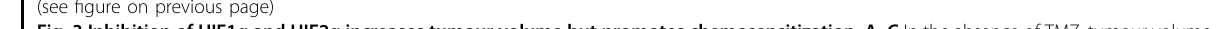
Fig. 3 Inhibition of HIF1 α and HIF2 α increases tumour volume but promotes chemosensitization. A – C In the absence of TMZ, tumour volume and weight were decreased after HIF1 α or HIF2 α -KO individually compared with the empty vector control, but the dual HIF1 α and HIF2 α knockout group had a larger tumour volume and tumour weight than the other three groups. After TMZ treatment (2 mg/kg), the tumour volume decreased after HIF1 α and HIF2 α knockout individually or simultaneously, and the smallest tumour volume was observed in the group with dual HIF1 α and HIF2 α knockout. In addition, the group with dual HIF1 α and HIF2 α knockout had the lowest tumour weight among all the groups. D , E In the absence of TMZ, the survival time became longer after HIF1 α or HIF2 α knockout individually, but the survival time was shorter in the dual HIF1 α and HIF2 α knockout group than in the other three groups (median survival time of the empty vector group vs HIF1 α -ko vs HIF2 α -ko vs HIF1 α /HIF2 α -ko group = 26 vs 31 vs 27.5 vs 22 days). However, after TMZ treatment (2 mg/kg), the HIF1 α or HIF2 α knockout group experienced prolonged survival, and the longest survival time was observed in the group with dual HIF1 α and HIF2 α knockout (median survival time of the empty vector group vs HIF1 α -ko vs HIF2 α -ko vs HIF1 α /HIF2 α -ko group = 30 vs 35 vs 34 vs 41 days). F The above cells were cultured in 1% O 2 for 72 h in the absence of TMZ, and there were no signi fi cant differences in cell proliferation between the HIF1 α -KO, HIF2 α -KO and control empty vector groups. However, after knocking out both HIF1 α and HIF2 α , the growth rate became the highest among all the groups. G The above cells were cultured in 1% O 2 for 72 h, and TMZ (400 μ M) was added to the culture medium for an additional 72 h. After HIF1 α or HIF2 α was knocked out individually, cell proliferation decreased. After both HIF1 α and HIF2 α were knocked out, the growth rate became the lowest among all the groups. H The above cells were cultured in 1% O 2 for 72 h, and TMZ (400 μ M) was added to the culture medium for an additional 72 h. The apoptosis rate increased after HIF1 α or HIF2 α knockout individually. After knocking out both HIF1 α and HIF2 α , the apoptosis rate became the highest among all the groups. The P value was determined by one-way ANOVA, and the survival time was analysed by the log-rank